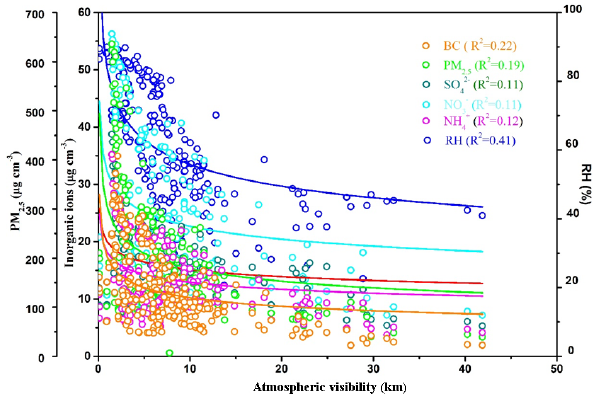
Figure 12. Scatter plots of RH, BC, PM 2 . 5 and inorganic ions in particles vs. atmospheric visibility. Table 1. Effective hygroscopicity parameters ( κ) and densities of the three category compositions.